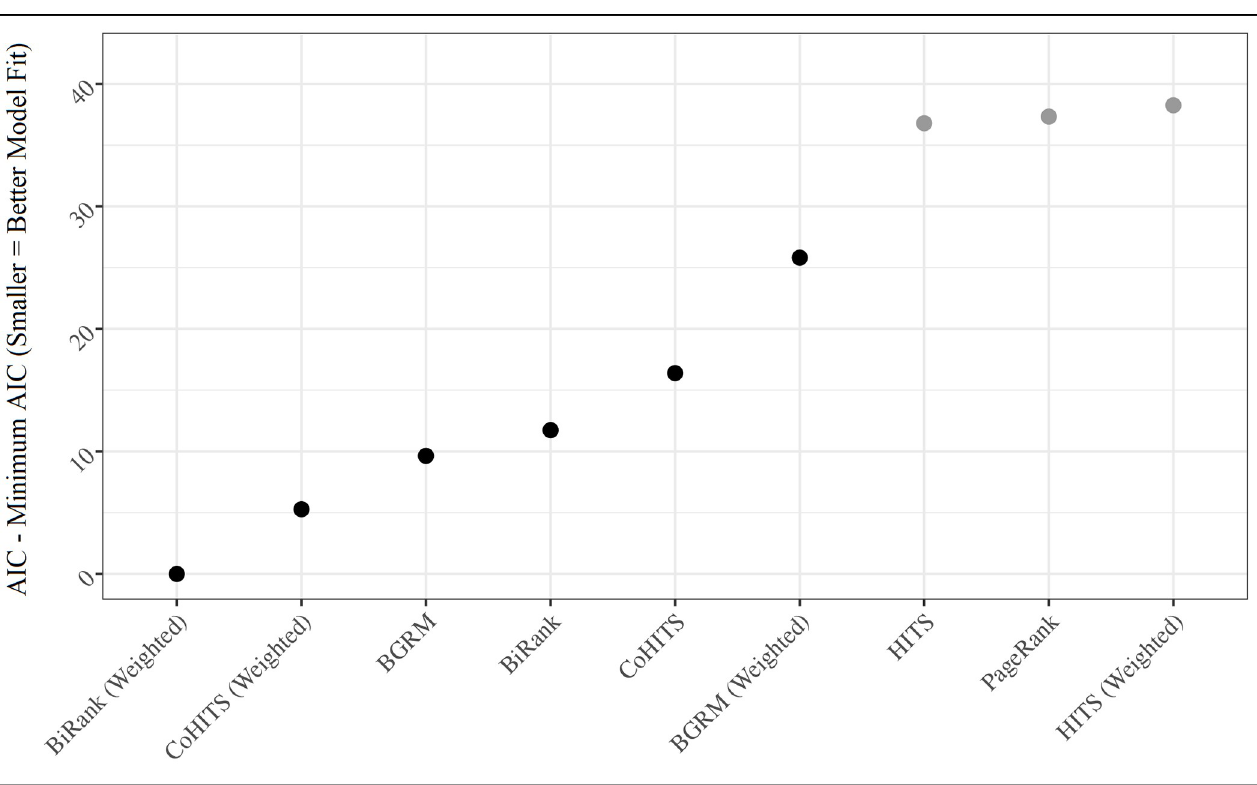
Fig 5. Model fit by rank parameter and MME-weighted edges. Dark points indicate parameter estimates that are statistically significant at p < 0.01. All parameter estimates have positive coefficients. Models control for age, gender (female), patient degree (number of providers), transitive ties, HEPC, HIV, cancer, psychological disorders, palliative care, and MAT